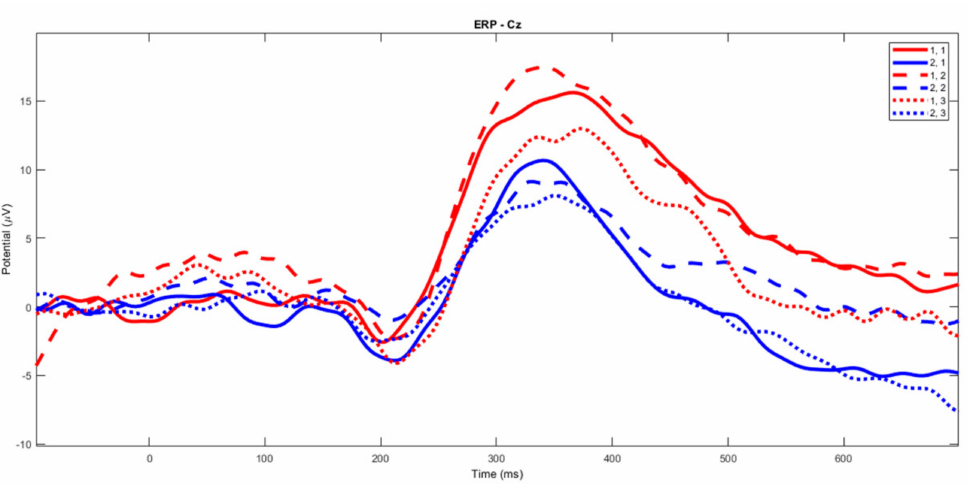
Figure 2. The grand average of the laser–evoked potentials on the right hand stimulation. The control group’s basal condition (1,1), slow finger tapping (1,2) and fast finger tapping (1,3); the fibromyalgia (FM) group’s basal condition (2,1), slow finger tapping (2,2) and fast finger tapping (2,3) (see also Figure